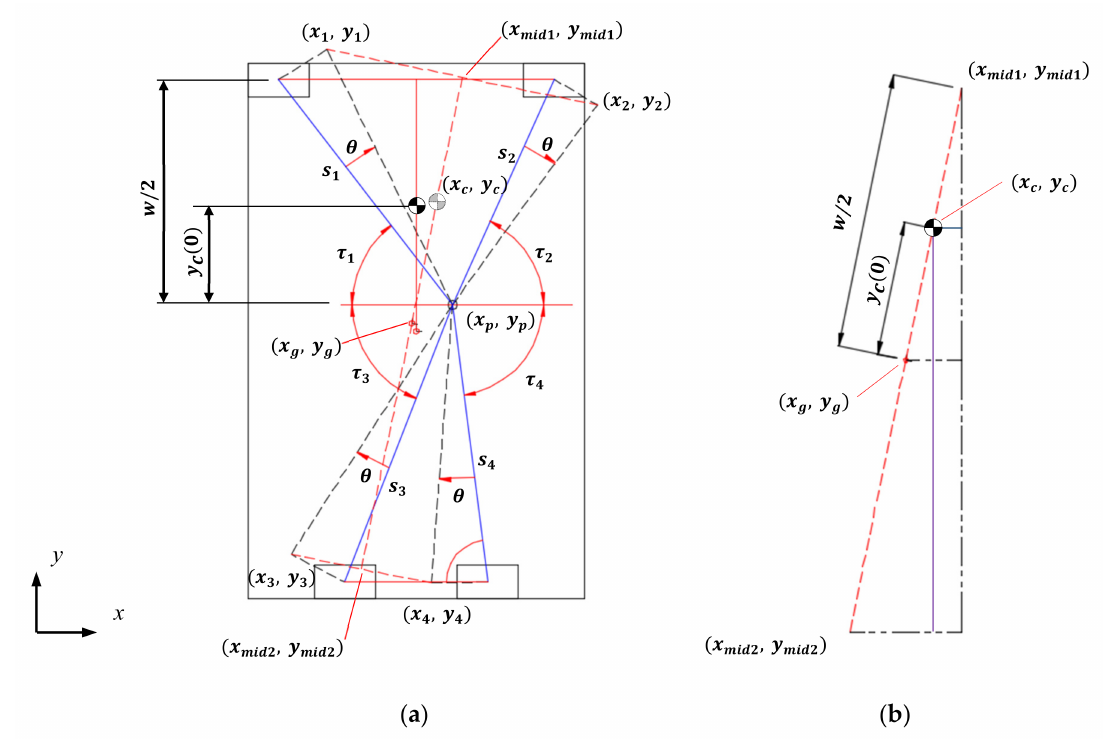
Figure 7. Schematic diagrams of ( a ) the relationship between the center of mass and the geometric center and ( b ) the zoomed view of the rotated center of